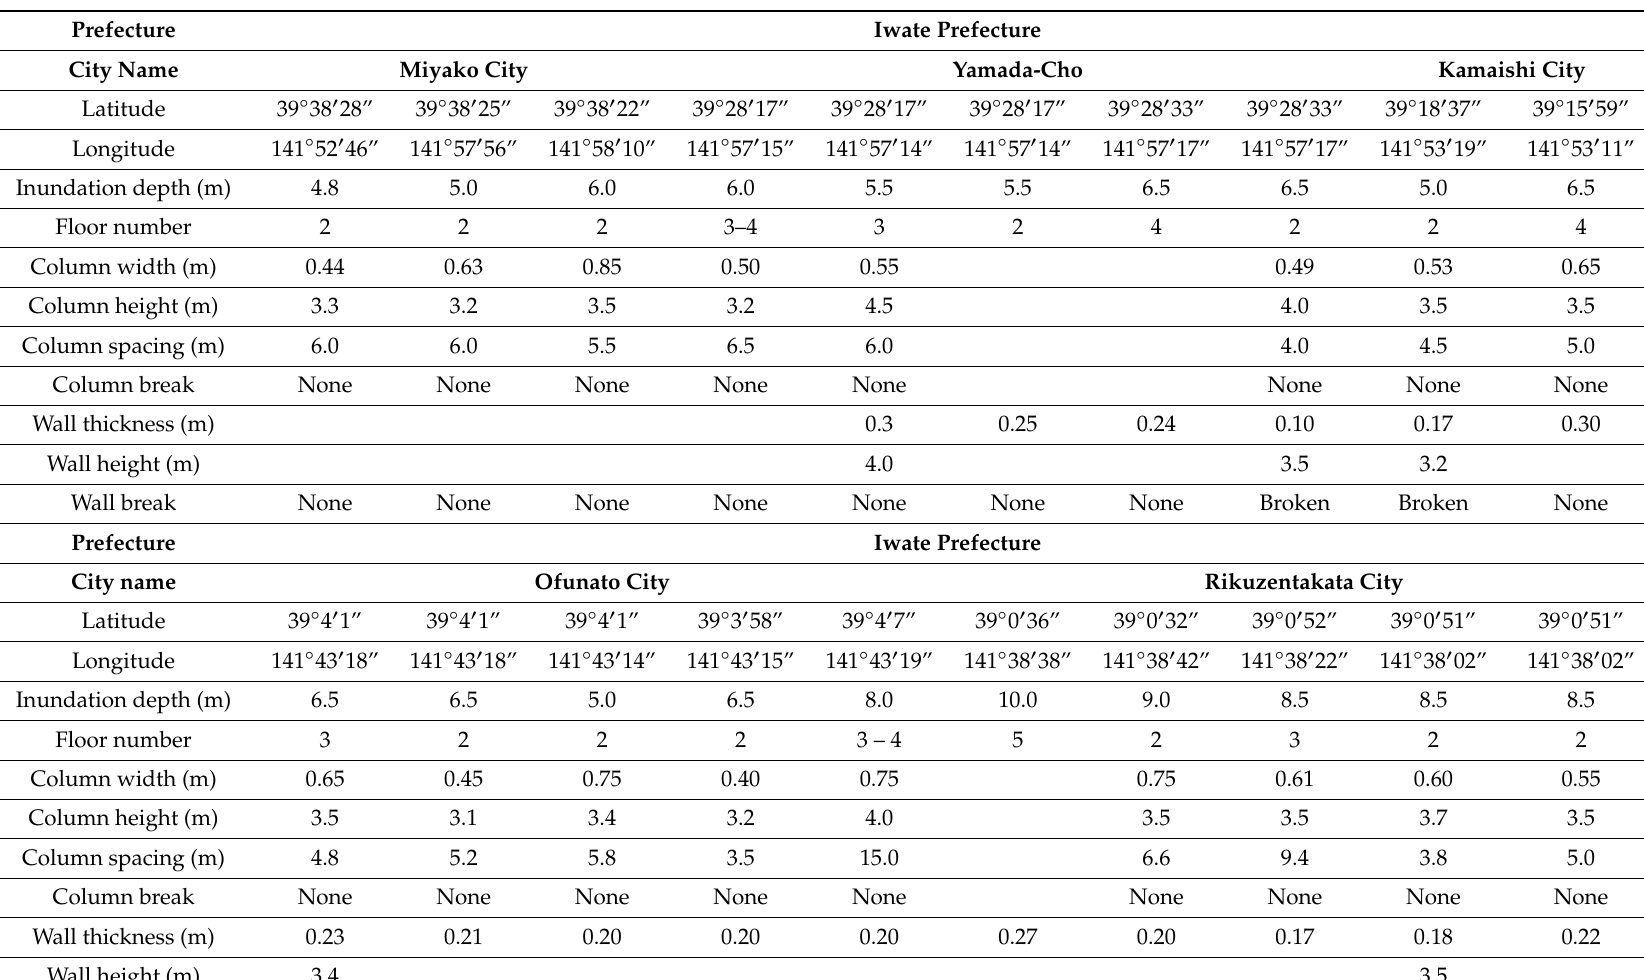
Table 2. The damage survey for reinforced concrete buildings during the 2011 Great East Japan Earthquake